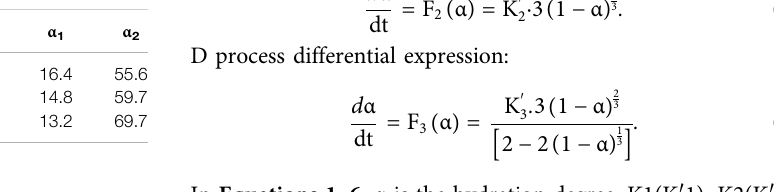
TABLE 2 | Dynamic parameters of the hydration process.